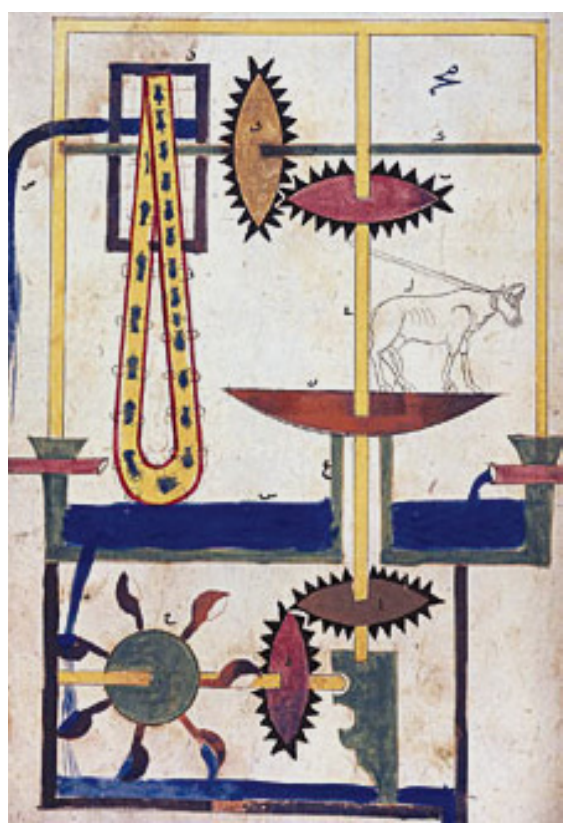
Figure 18. Α l-Jazari’s hydropowered saqiya chain pump device (adapted from